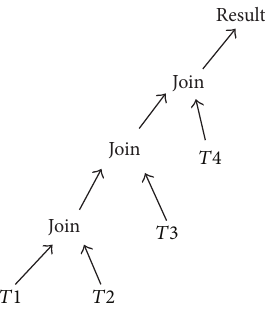
Figure 1: Left-deep